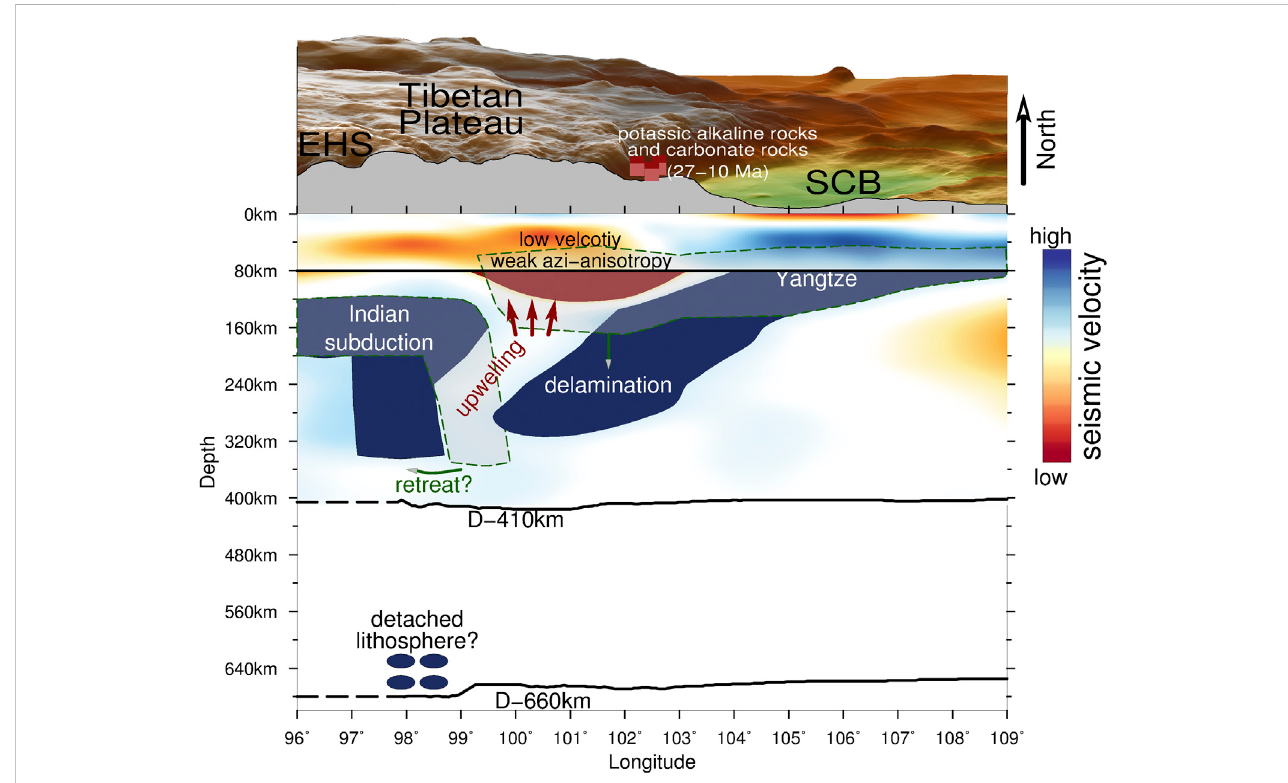
FIGURE 6 Deep tectonics of the eastern Tibetan Plateau. Seismic velocity perturbations in the upper mantle and crust are collected from this study and Bao et al., 2020, respectively. Thedepth ofLAB,410and 660 kmdiscontinuities are retrievedfromZhang etal.,2010 andZhang etal., 2017. Redhexahedronsrepresent the western Sichuan potassic alkaline rocks and carbonate rocks (27 – 10 Ma), which are collected form Hou et al.,